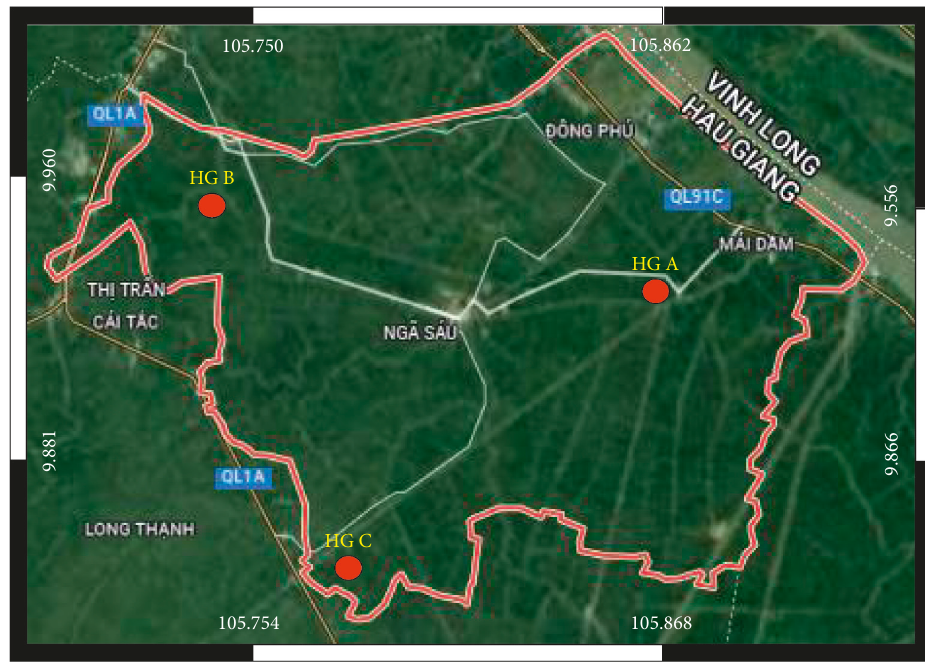
Figure 1: Location of the conducted